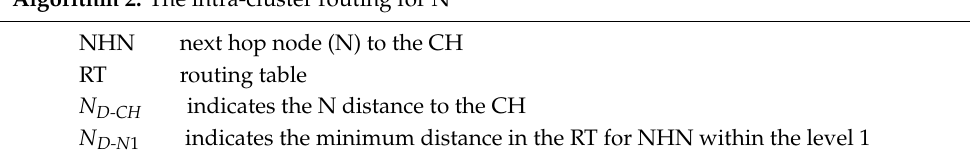
Algorithm 2: The intra-cluster routing for